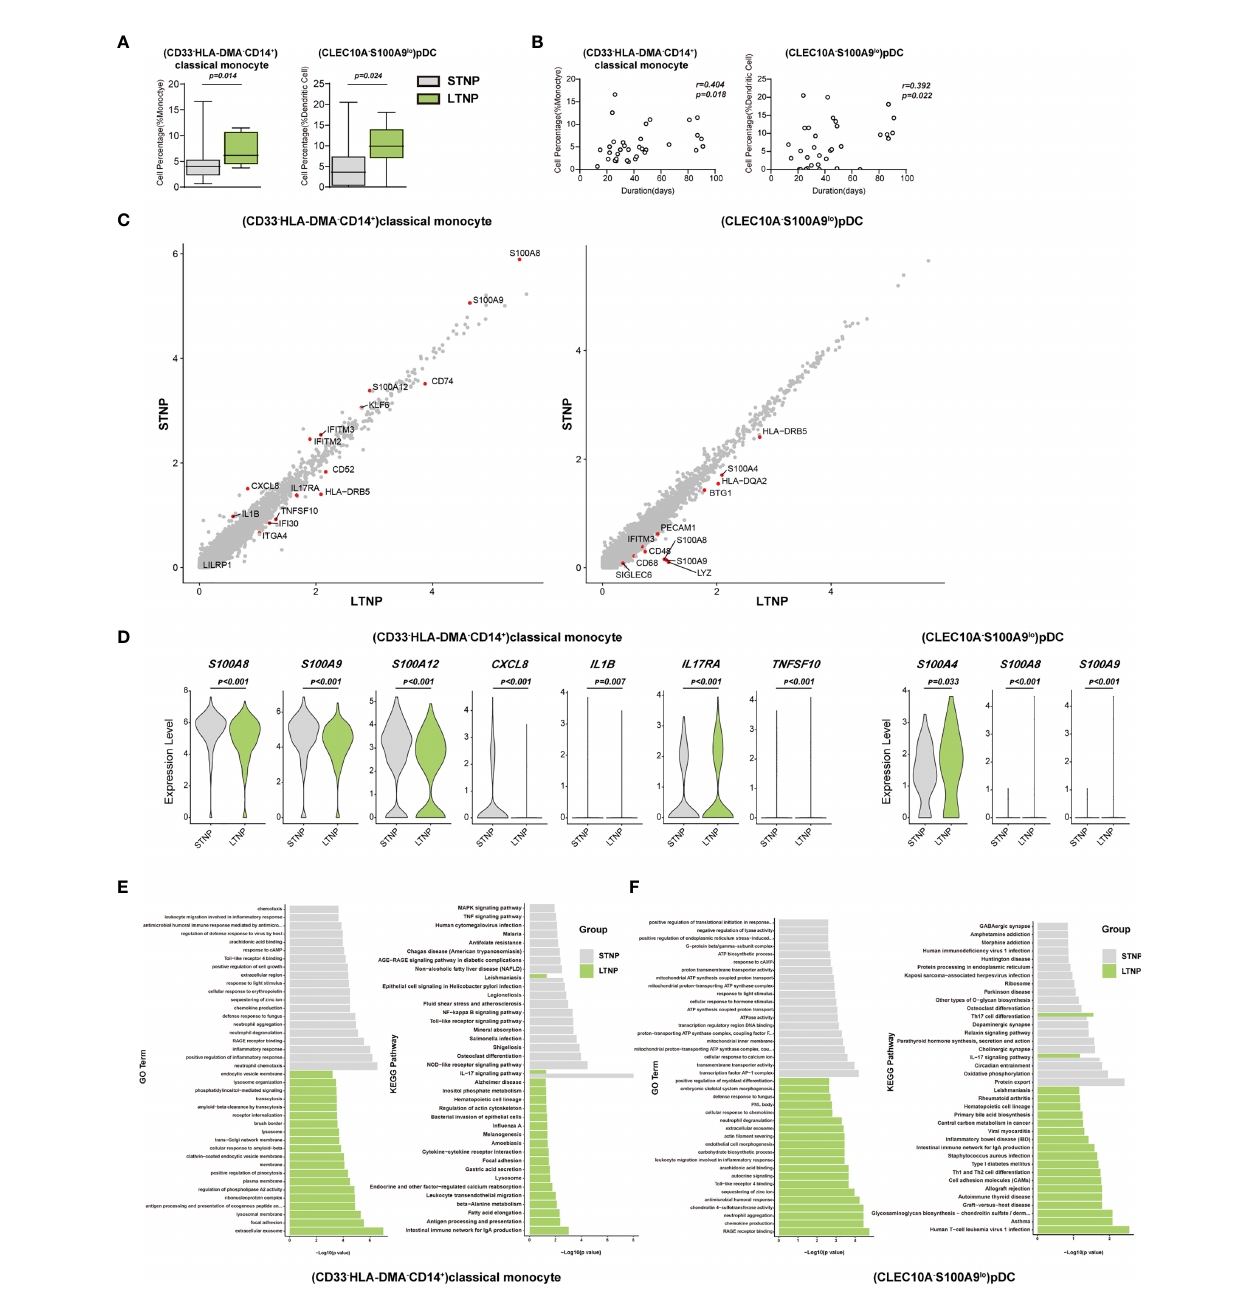
FIGURE 6 | (CD33-HLA-DMA-CD14+)classical monocytes and (CLEC10A-S100A9lo)pDC were positively correlated with the viral persistence. (A) The Box and whisker plots showing the percentage of (CD33 - HLA-DMA - CD14 + )classical monocytes and (CLEC10A - S100A9 lo )pDC that had signi fi cant differences (p <0.05) between the STNP and LTNP groups, respectively. The horizontal lines, box and whiskers correspond to median values, interquartile range (IQR) and minimum/ maximum value, respectively. (B) Spearman rank order correlation analysis showing the (CD33 - HLA-DMA - CD14 + )classical monocytes and (CLEC10A - S100A9 lo )pDC were positively correlated with the viral persistence. (C) The M-versus-A (MA) plots showing the differentially expressed genes (DEGs) in the (CD33 - HLA-DMA - CD14 + ) classical monocytes and (CLEC10A - S100A9 lo )pDC with p <0.05 and log2 fold change (FC) ≥ 0.26 in STNP and LTNP. The gene expression was calculated via LogNormalize method of the “ NormalizeData ” function of the Seurat software. The X and Y axis represent log (1+average expression value), respectively. (D) The violin plots showing the expression levels of seven representative DEGs ( S100A8, S100A9, S100A12, IL17RA, TNFSF10, CXCL8 , and IL1B ) in (CD33 - HLA-DMA - CD14 + )classical monocytes and three representative DEGs ( S100A4, S100A8, S100A9 ) in (CLEC10A - S100A9 lo )pDC. (E) Gene Ontology (GO) and KEGG analysis for (CD33 - HLA-DMA - CD14 + )classical monocytes. Top 20 signi fi cant GO terms and KEGG pathways sorted by − log10 (p value) from STNP and LTNP were shown. (F) GO and KEGG analysis for (CLEC10A - S100A9 lo ) pDC. Top 20 signi fi cant GO terms and KEGG pathways sorted by − log10 (p value) from STNP and LTNP were shown (also see Figure S5 ). p <0.05 was considered signi fi cant. The samples included LTNP (n=12) and STNP